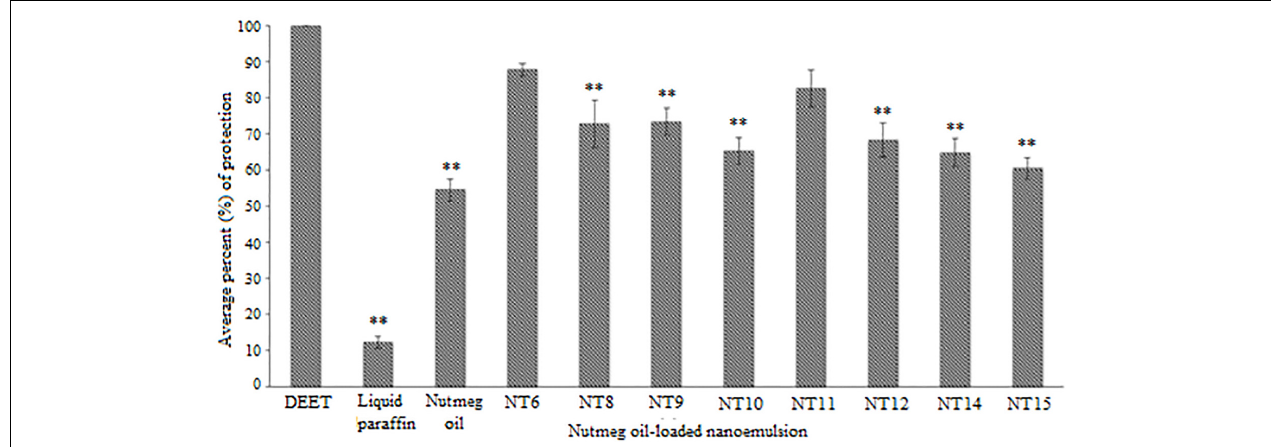
FIGURE 4 | Average percentage protection against mosquitoes provided by controls, nutmeg oil, and selected NTs for 8 h (Mean ± SD, n = 3). ∗∗ p < 0.01 (Dunnett t -test).